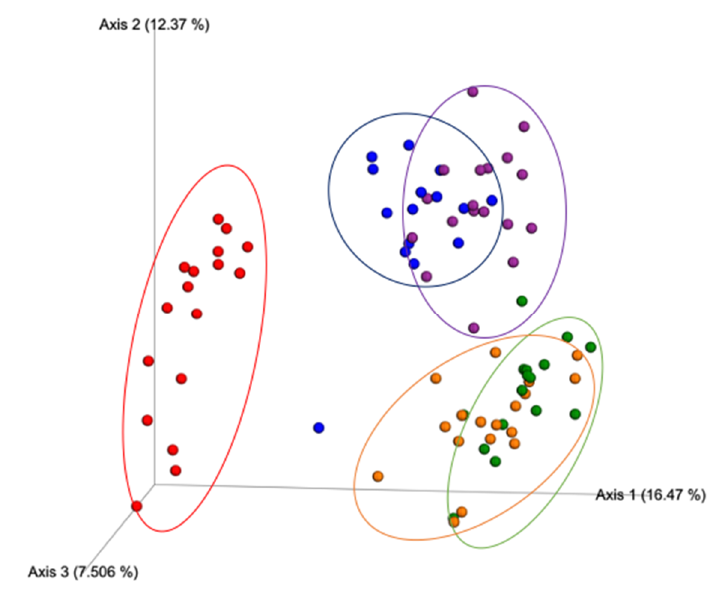
Figure 5. Beta diversity PCoA plot of between-group distances using unweighted UniFrac distance matrix values. Treatment groups are as follows: control, red; high-fat, high-sugar diet (HFD), blue; HFD + genistein (Gen), purple; HFD + exercise (Exe), orange; HFD + Exe + Gen, green. Significant group differences ( p < 0.05) after Benjamini–Hochberg correction for multiple comparisons were observed for all pairwise treatment comparisons.